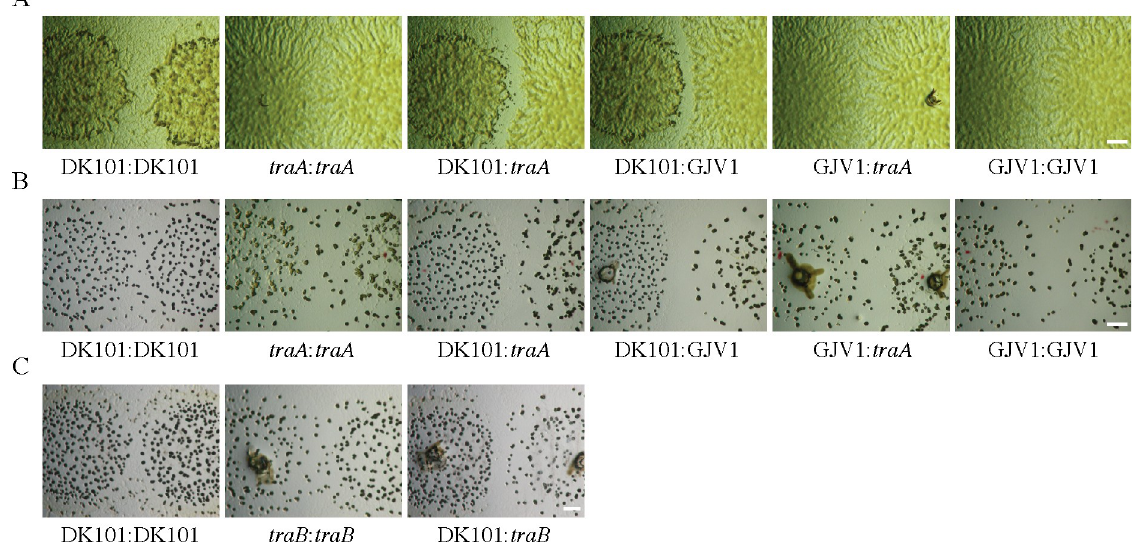
Fig 2. Disruption of traA or traB does not eliminate a CMI between GJV1 and DK101. Colony-encounter phenotypes in pairings of GJV1, GJV1 traA (abbreviated to ‘ traA’ below images), and DK101 on 0.3% ( A ) and 0.1% ( B ) casitone media. For both A and B, colonies merge freely in self-self encounters of GJV1, GJV1 traA and DK101 and in the non-self encounter of GJV1 and GJV1 traA . In the left-most image of row A , the two DK101 colonies have darker center regions surrounded by distal regions that are less opaque but are nonetheless covered by cells. In this image, DK101 cells are continuous across the entire colony-interface region and do not exhibit a CMI phenotype. In contrast, strong CMI demarcations are formed in non-self encounters between DK101 and both GJV1 and GJV1 traA . C . Interfaces between GJV1 traB (abbreviated to ‘ traB’ below images) and DK101 colonies growing on 0.1% casitone also exhibit a clear CMI whereas self-self interfaces do not. Scale bars: 1 mm.